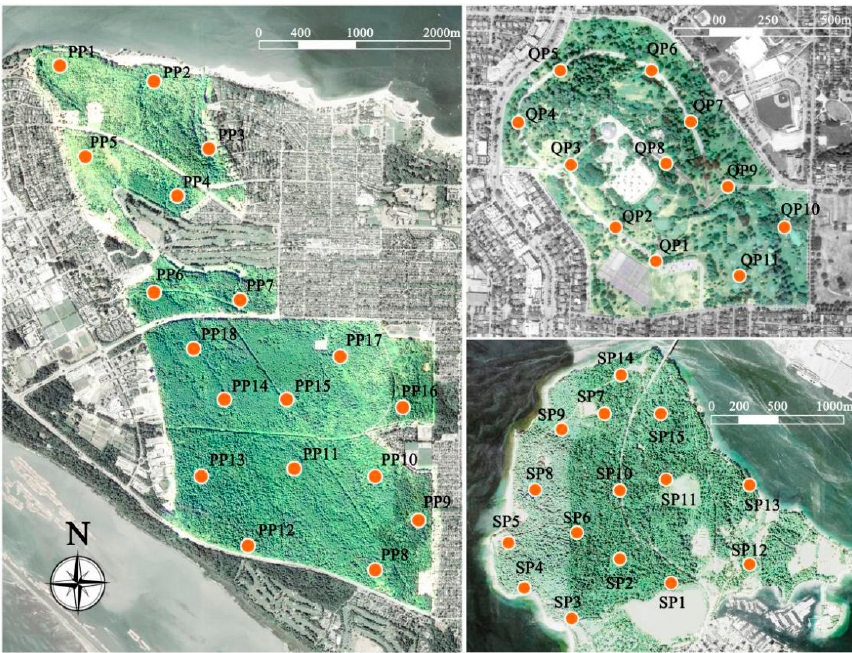
Figure 1. Aerial photo of Pacific Spirit Park (PP), Stanley Park (SP), and Queen Elizabeth Park (QP).